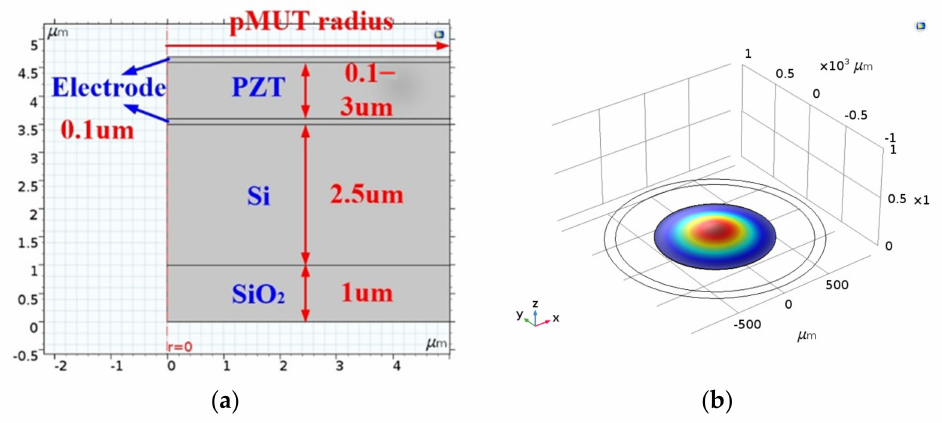
Figure 3. FEM of the pMUT device: ( a ) design structure of the pMUT; ( b ) finite element model of the